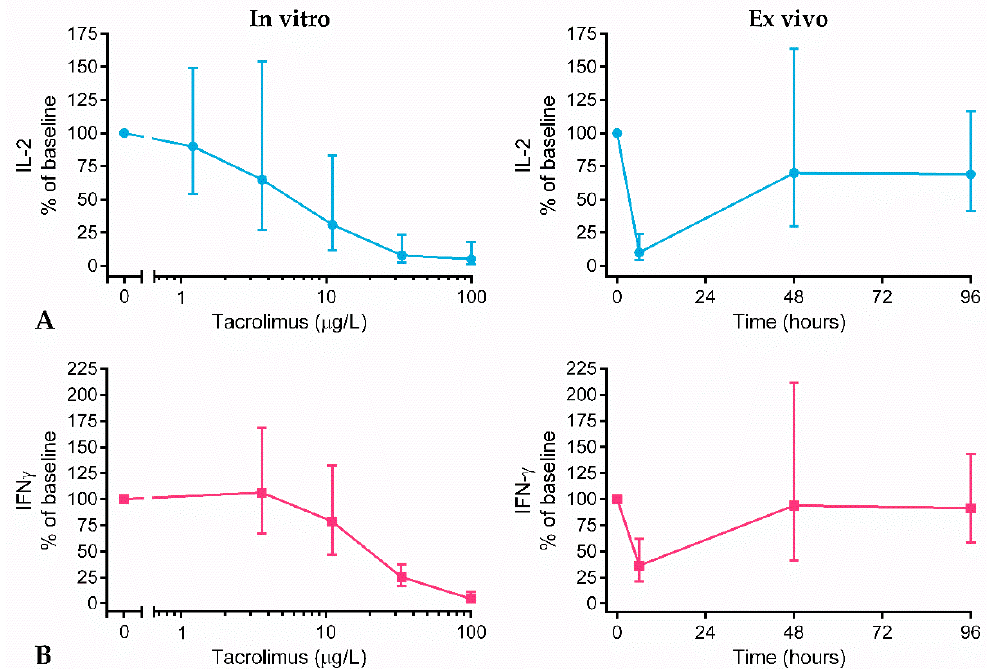
Figure 2. In vitro and ex vivo tacrolimus e ff ect on cytokine production. ( A ) IL-2 production (blue lines) and ( B ) IFN γ production (red lines) in phytohemagglutinin (PHA)-stimulated whole blood. In vitro tacrolimus e ff ect: pre-dose cytokine production after incubation with decreasing doses of tacrolimus (100, 33, 11, 3.7, and 1.2 µ g / L). Ex vivo tacrolimus e ff ect: cytokine production at 0 h, 1.5 h, 48 h, and 96 h after dosing. The cytokine production is calculated as percentage of baseline, and is displayed as mean ± SD.